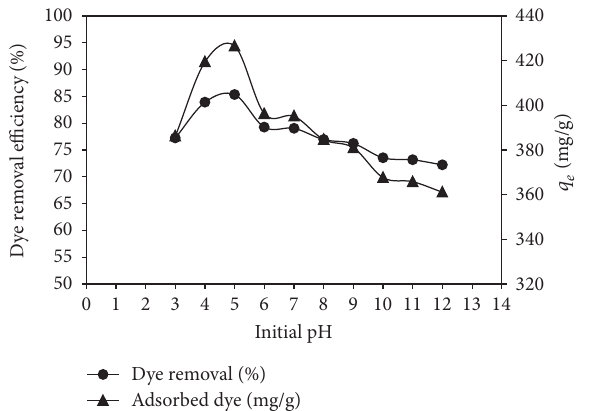
F 5: Effect of contact time on RR-120 adsorption onto SWCNTs. ( 𝐶𝐶 0